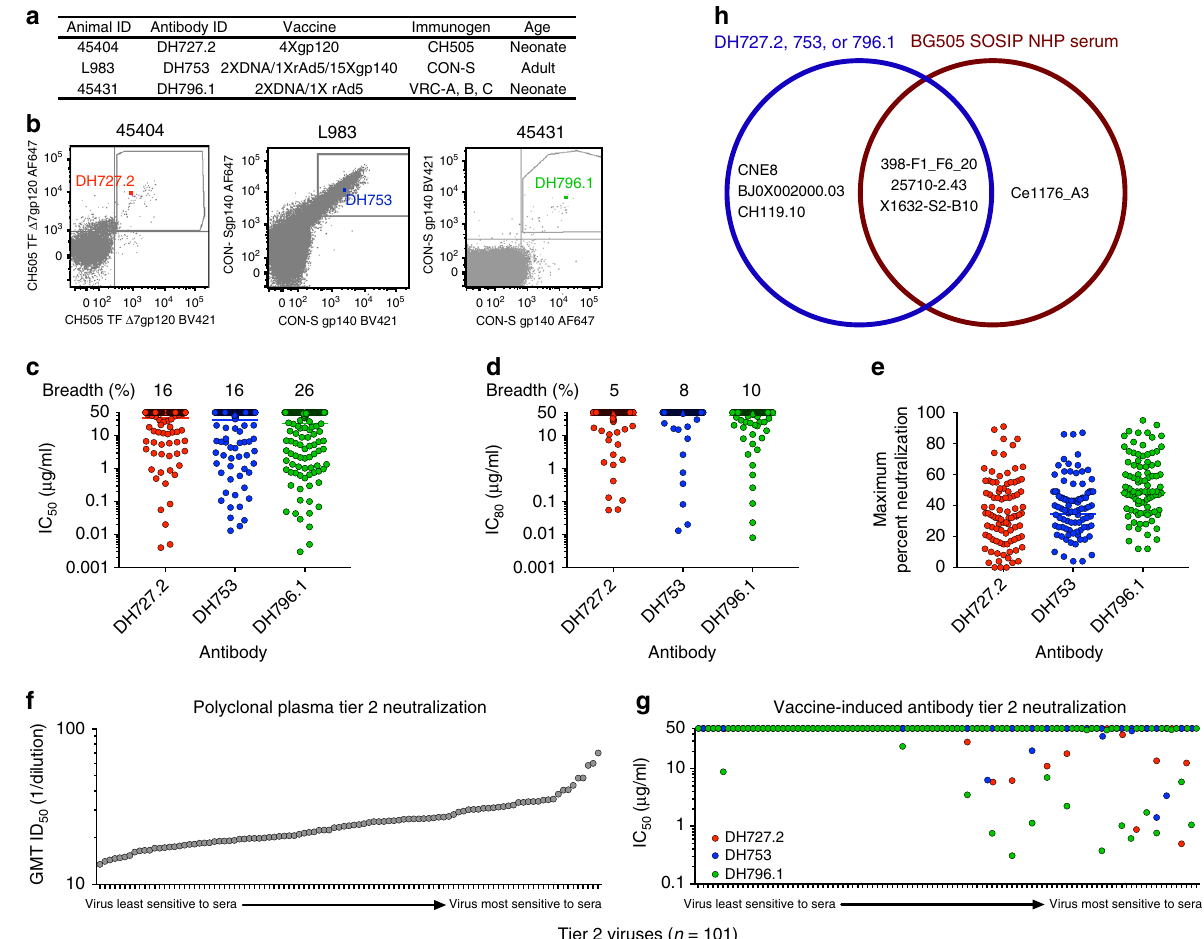
Fig. 1 Vaccine-induced antibodies neutralize tier 2 viruses. a Summary of the vaccine regimens and macaque demographics from which the three antibodies DH727.2, DH753, and DH796.1 were isolated. b Antigen-speci fi c single B cell sorting of vaccinated macaque PBMCs. Antigen-speci fi c single B cells were isolated with fl uorophore-labeled CH505 gp120 or CON-S gp140 as indicated on the x and y -axes. The B cell encoding the antibody of interest is shown as a colored square in the FACS plot. c , d In vitro antibody neutralization of HIV-1 infection of TZM-bl cells. Each symbol signi fi es one of the 292 HIV-1 isolates tested. Neutralization titers are represented as the concentration in µ g mL ‒ 1 that inhibits c 50% or d 80% of virus replication (IC50 or IC80 respectively). SIVmac239 and MuLV were used as negative controls and titers for both viruses were > 50 µ g mL ‒ 1 . Horizontal bar indicates the geometric mean neutralization titer of all isolates. The neutralization breadth is shown above each column as the percentage of viruses neutralized by 50% c or 80% d . e Maximum percent neutralization achieved by each vaccine-elicited antibody against 93 early/acute tier 2 clade C HIV-1 isolates. Each symbol signi fi es one HIV-1 isolate. Horizontal bar indicates the mean maximum percent neutralization. f , g Vaccine-induced antibodies preferentially neutralize the most sensitive tier 2 viruses. Polyclonal plasmas from HIV-1 infected individuals were used to phenotype 101 HIV-1 isolates as tier 2 viruses f . The plasma dilution that inhibited 50% of virus replication (ID50) for each virus is shown for all serum samples as the geometric mean titer (GMT). The viruses are ordered according to increasing sensitivity to the polyclonal sera neutralizing antibodies. g Vaccine-induced antibodies DH727.2 (red), DH753 (blue), and DH796.1 (green) neutralization titers as IC50 in µ g mL ‒ 1 for the 101 tier 2 HIV-1 isolates shown in f . h Venn diagram showing the overlap of viruses from the 12-virus global panel that were neutralized by DH727.2, DH753, DH796.1 isolated from vaccination and macaque immune sera from monkeys immunized with BG505 SOSIPs 29 . Five of the viruses were not neutralized by DH727.2, DH753, DH796.1 or BG505 SOSIP-immune sera. Source data are provided as